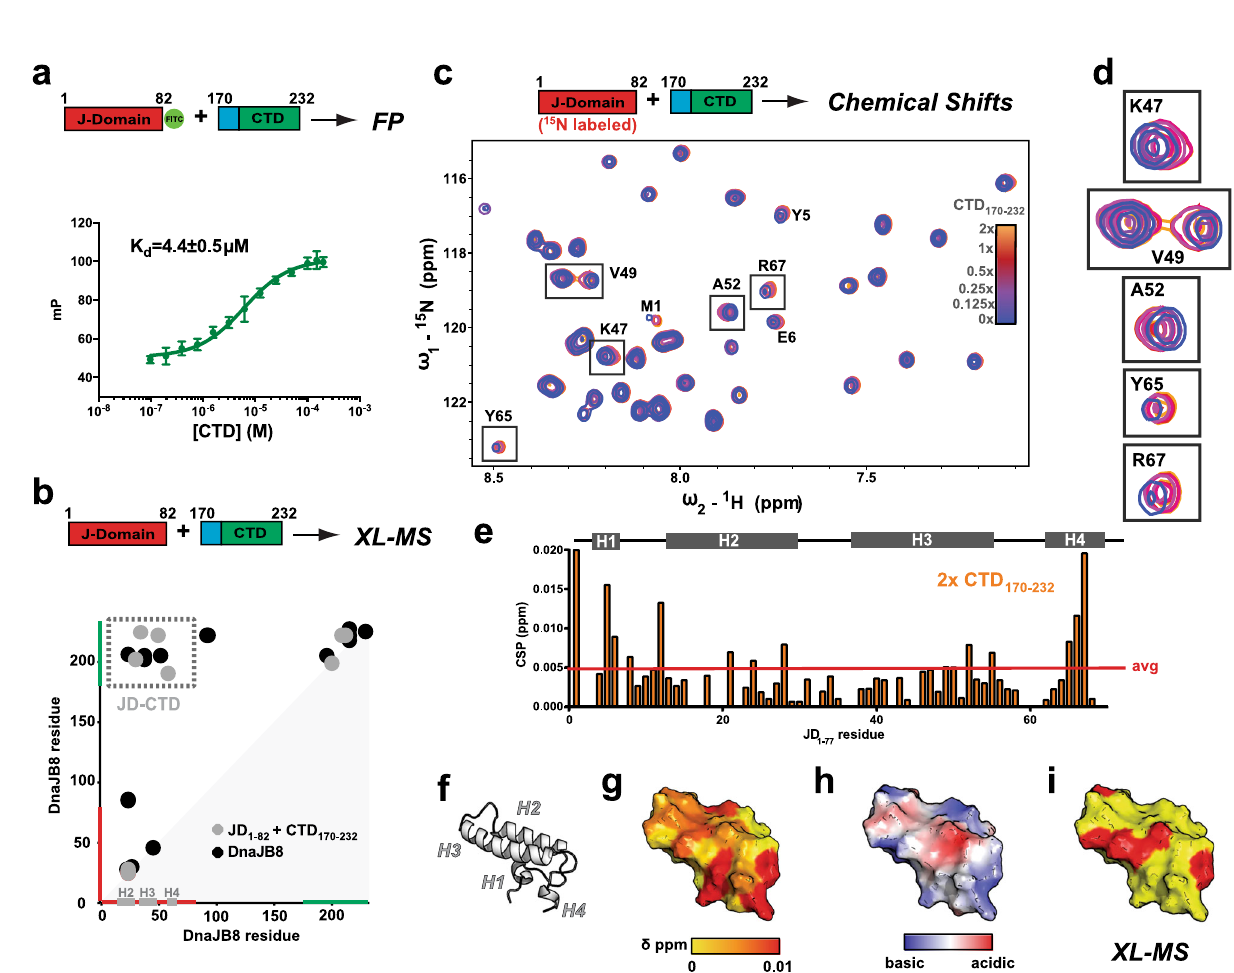
Fig. 4 Isolated JD and CTD proteins are monomeric. a Cartoon schematic for the full-length DnaJB8 and domain fragments JD 1 – 82 and CTD 170 – 232 . b Representative SEC pro fi les of JD 1 – 82 (red), CTD 170 – 232 (green), and LMW standards (blue). JD 1 – 82 and CTD 170 – 232 elute at apparent molecular weights of 14 and 6.5 kDa, respectively. c SDS-PAGE Coomassie gel of cross-linked JD 1 – 82 and CTD 170 – 232 reacted with either DMTMM only or DMTMM with ADH. This experiment was performed three independent times. d Contact map of ADH/DMTMM cross-links identi fi ed for JD 1 – 82 (red), CTD 170 – 232 (green), and full-length DnaJB8 (black). The axes are colored in red and green for JD and CTD, respectively. Cross-link pairs between JD – JD and CTD – CTD are shown in dashed boxes colored in red and green, respectively. e Histogram of the number of intra-domain cross-links that are consistent with cross-link chemistry geometry ( “ satis fi ed ” ) in the ensemble of 5000 models. One model satis fi es 13 out of 14 possible cross-links identi fi ed in our experiments. Cross-links are mapped onto best matching CTD structural model (inset), shown in white cartoon representation. Sites of cross-link are shown as red or blue spheres, for D/E and K, respectively. Dashed yellow lines connect linked amino acid pairs. f Overlay of our DnaJB8 CTD model generated by ab initio ROSETTA (green) with the published DnaJB6b Δ ST CTD (salmon) (PDB ID: 6U3R). The CTD sequences of DNAJB8 and DNAJB6 are shown with each β -strand highlighted and conserved NG and DG turns in blue.